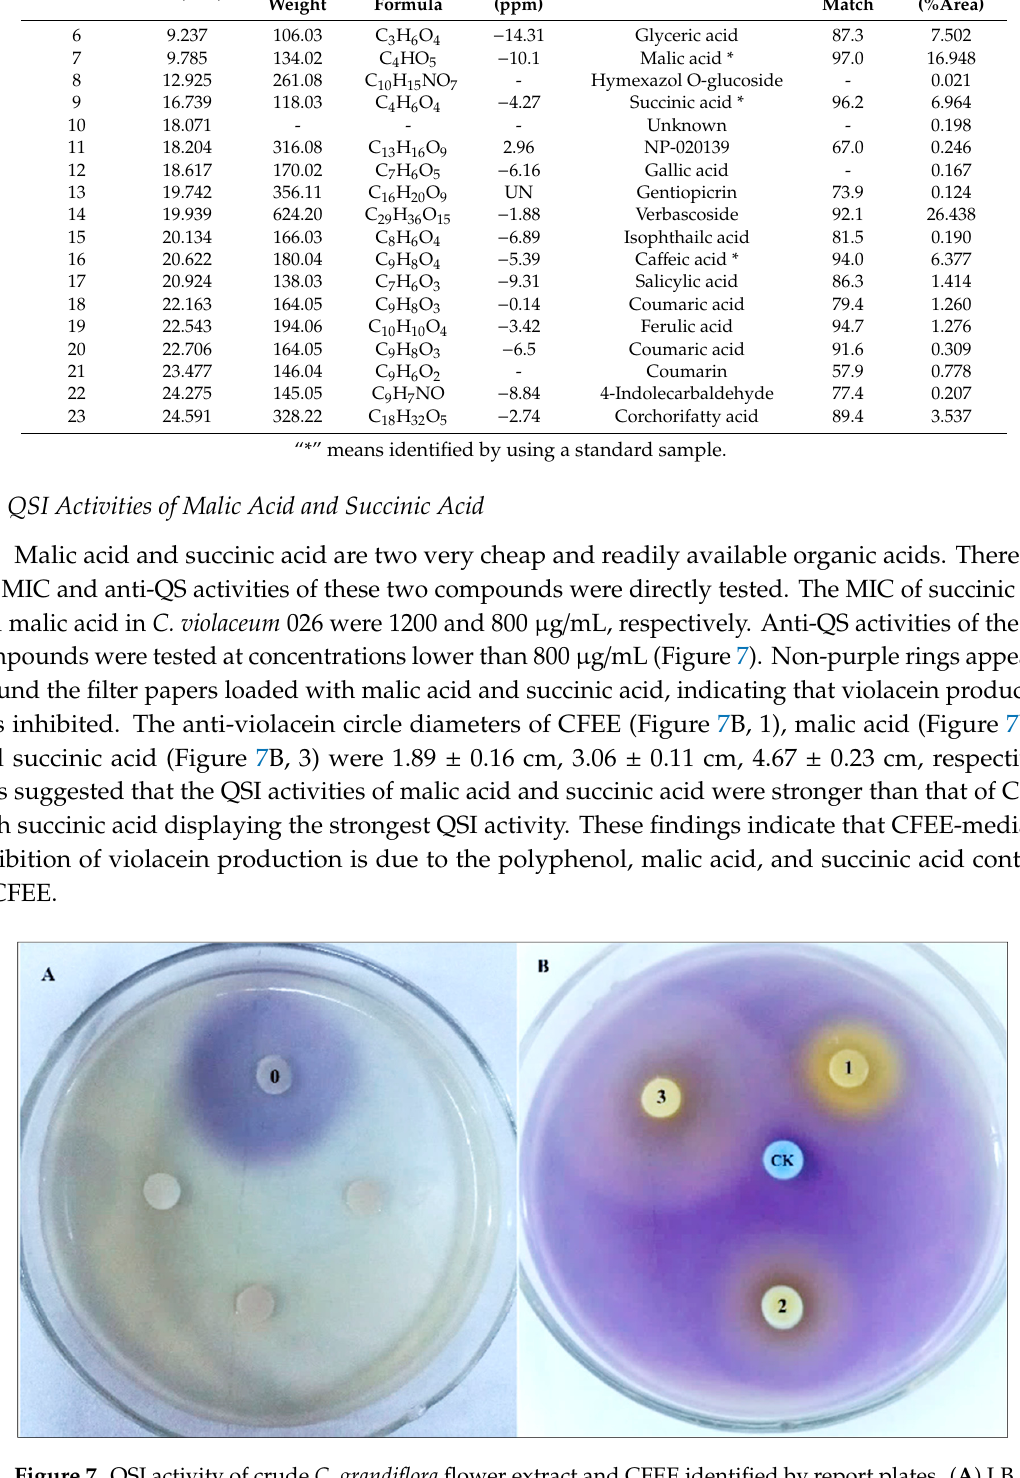
Figure 7. QSI activity of crude C. grandiflora flower extract and CFEE identified by report plates. ( A ) LB agar plate incubated by C. violaceum 026; ( B ) LB agar plate supplemented by C 6 -HSL and incubated by C. violaceum 026; “CK”, methanol as negative control; “0”, C 6 -HSL; “1”, CFEE; “2”, 200 μ g/mL succinic acid; “3”, 200 μ g/mL malic acid.